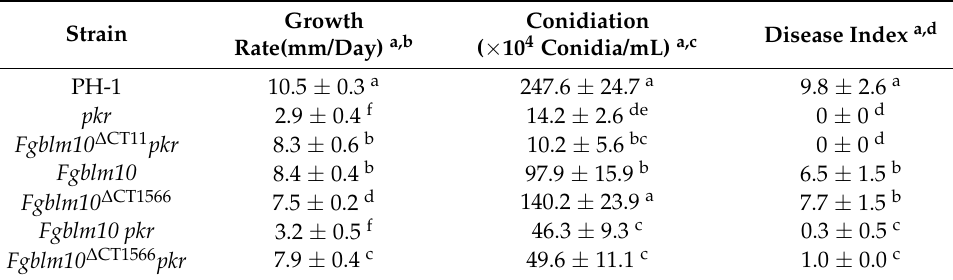
Table 3. Phenotypes of the FgBlm10 mutant and its transformant strains in growth, conidiation, and plant